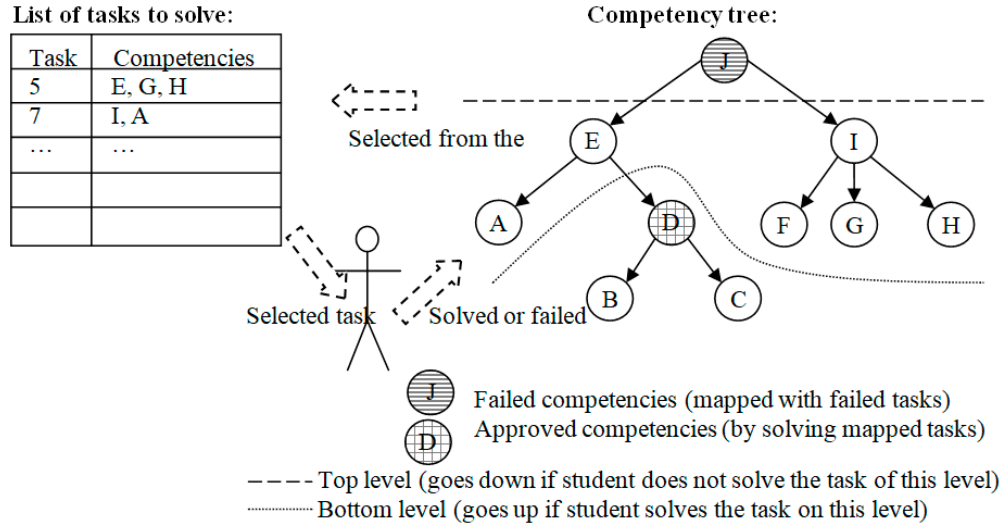
Figure 5. Example of student’s evaluation system - when the tasks to be solved are selected according to previously solved and failed